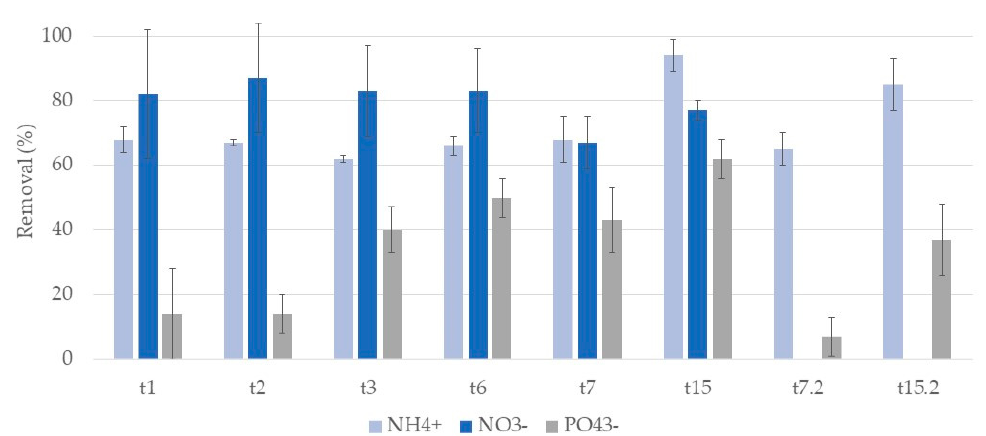
Figure 9. Removal percentage and respective standard deviation (n = 3) for each nutrient ion, in CWs with expanded clay (A) and T. latifolia during the two cycles of treatment. First cycle: samples taken after one day (t1), two days (t2), three days (t3), five days (t5), six days (t6), seven days (t7), and at the end of the two-week cycle (t15). Second cycle: samples taken after one week (t7.2) and at the end of the two-week cycle (t15.2) of treatment.